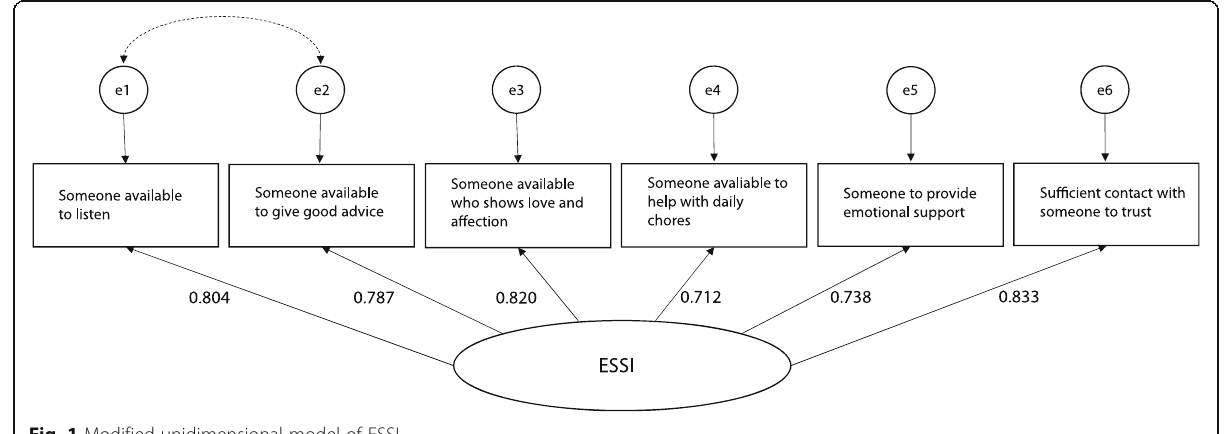
Fig. 1 Modified unidimensional model of ESSI